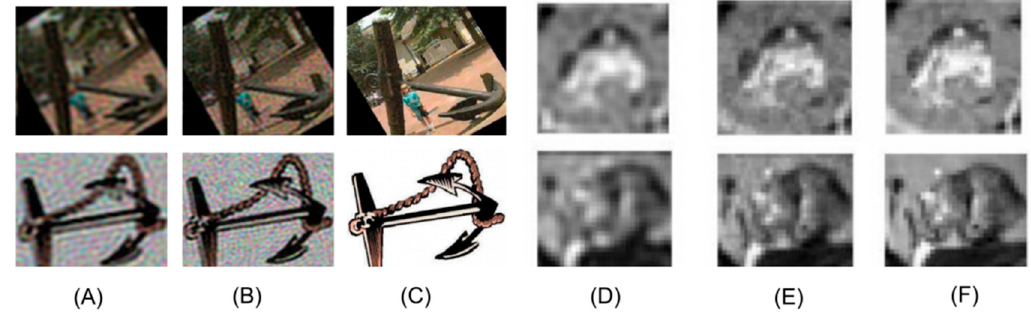
Appl. Sci. 2021 , 11 , x FOR PEER REVIEW 11 of 15 Figure 9. ( A ) Lower resolution CalTech 101 image, ( B ) FPM reconstructed CalTech 101 image ( C ) Original CalTech 101 image ( D ) Lower resolution Fashion CIFAR image ( E ) FPM reconstructed CIFAR image ( F ) original CIFAR image.